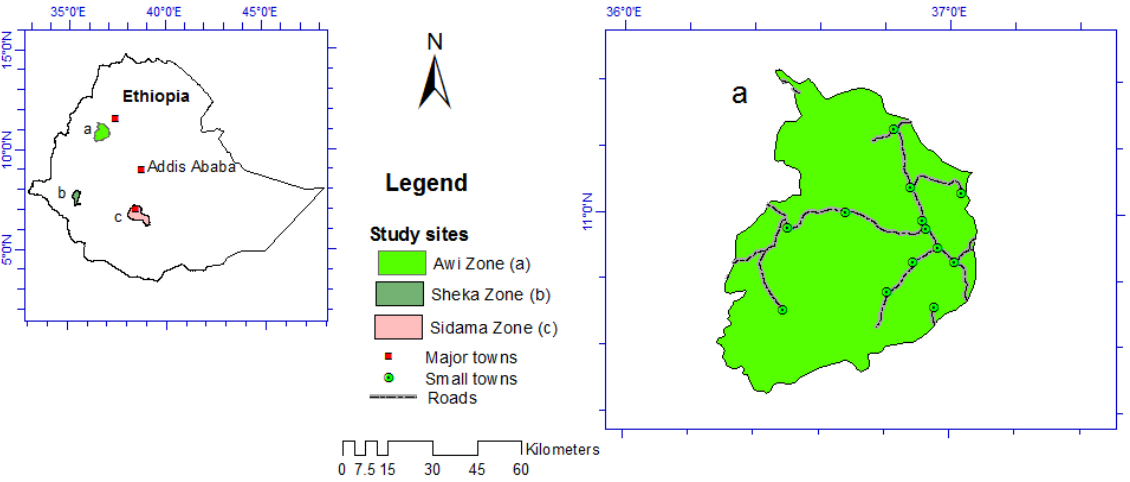
Figure 1. Location of the study districts in relation to the country